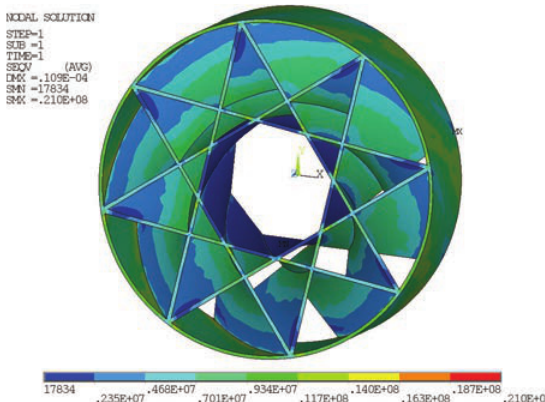
Fig.10.Von Misses distribution of 8B impeller